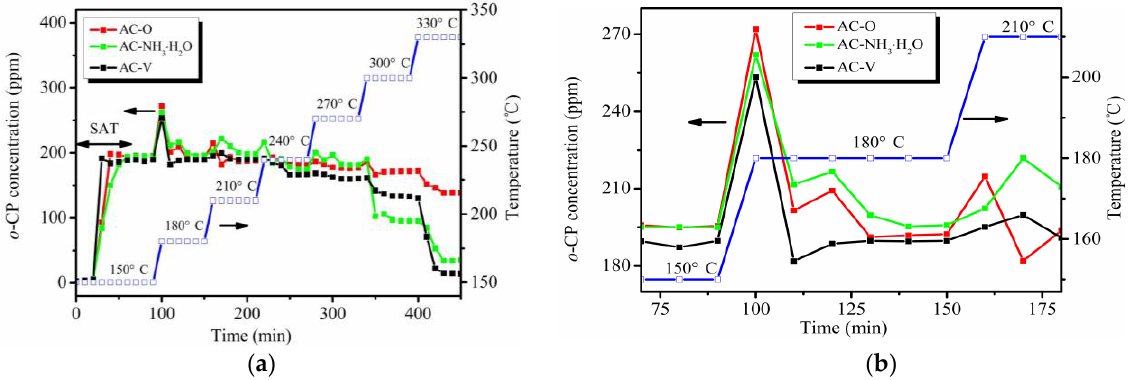
Figure 1. ( a ) Evolution of the downstream ortho-chlorophenol ( o -CP) concentration during the catalytic test. ( b ) Local magnification from 150 to 210 °C of panel ( a ).